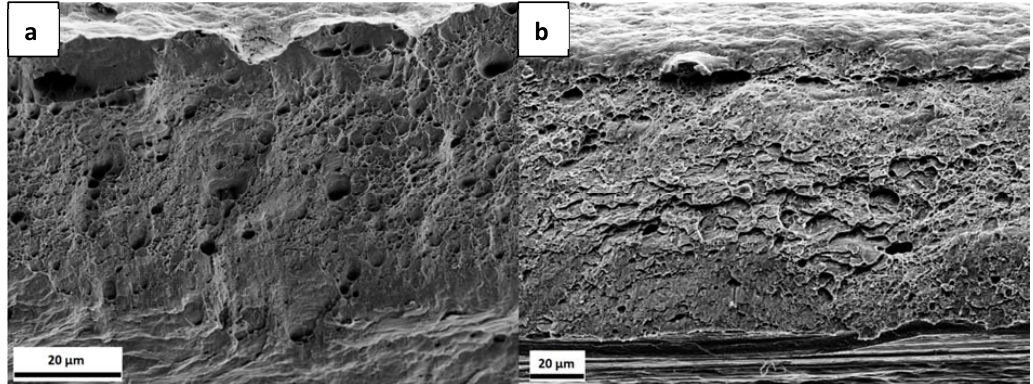
Figure 13. Fracture surfaces of the ( a ) uncharged and ( b ) charged and discharged CP steel specimens.